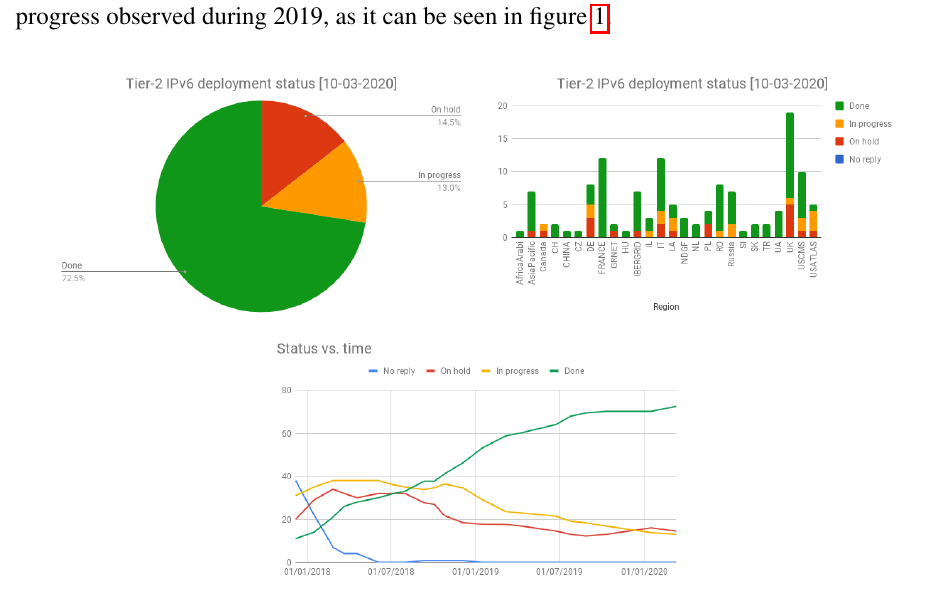
Figure 1. (left) Tier-2 deployment status by site globally, (right) by region, and (bottom) time